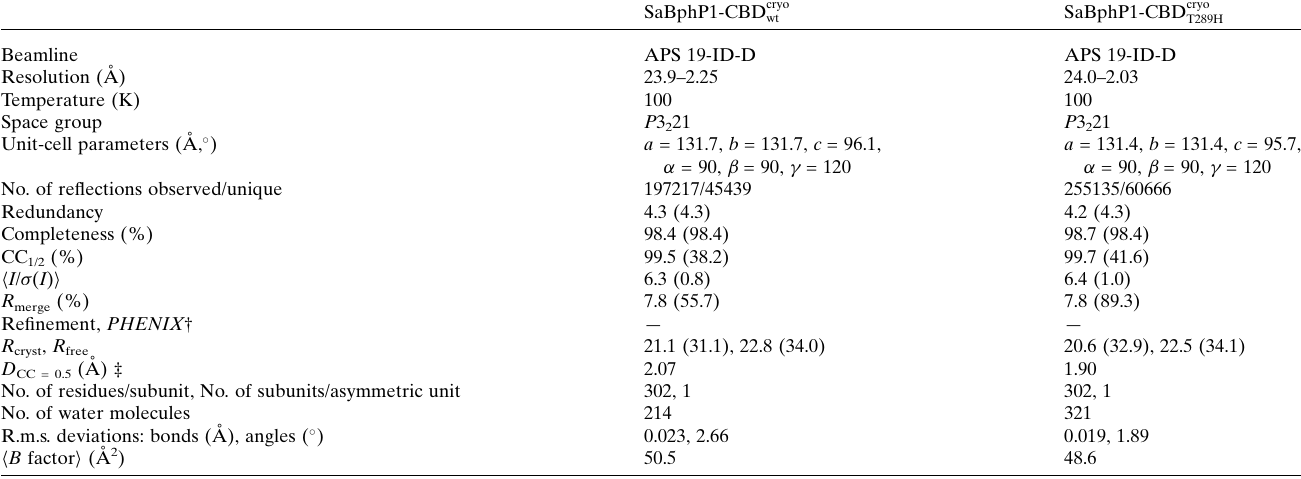
A , B and C in the asymmetric unit, but the PCM-wt molecule in the asymmetric unit. The PCM crystals diffracted respectively (Appendix B , Table 1 a ). In the mutant PCM crystals, subunits A and B form a non-crystallographic dimer, and the third subunit, C , is related to its mate through a crystallographic twofold symmetry. The density of subunit C is not as good as for subunits A and B , since large parts of the PHY domain are disordered (Appendix B , Table 1 a ). Using the SACLA XFEL, a data set to 3.15 A˚ resolution was